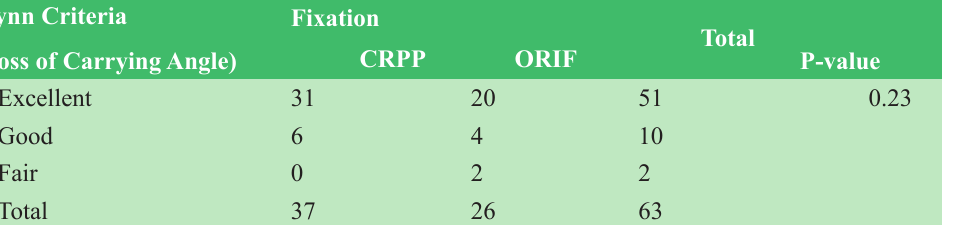
Table 3: Outcome According To Flynn’s Criteria Vs Type of Fixation Flynn Criteria (Loss of Carrying